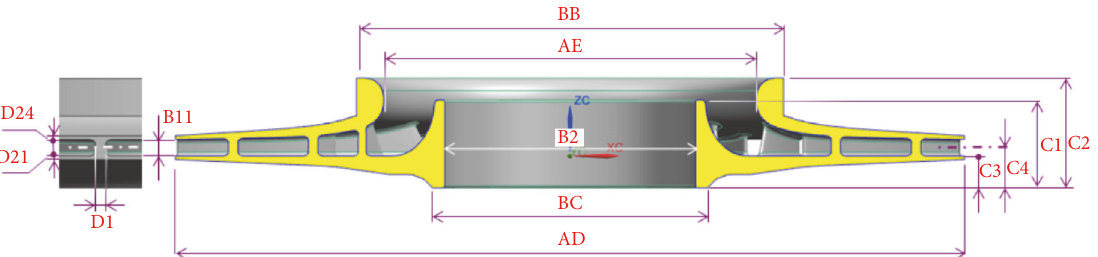
Figure 10: Dimension definition for geometrical control.